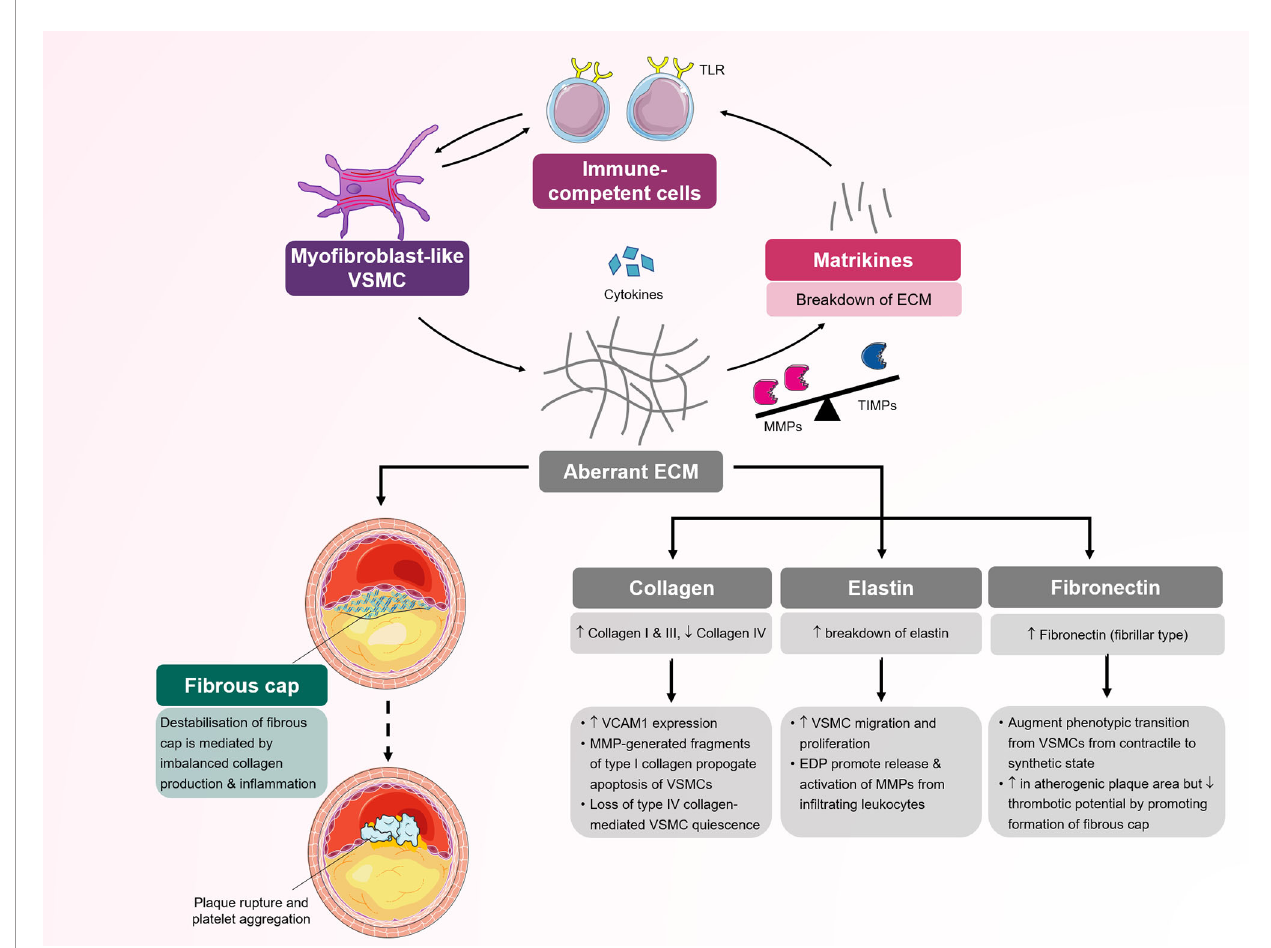
FIGURE 2 | The roles of different vascular smooth muscle cell (VSMC) phenotypes in the initiation, progression and sequelae of atherosclerotic lesions. The normal artery has a trilaminar structure. The adventitia (outermost layer) contains vasovasrum, mesenchymal stem cells and collagen. The tunica media (middle layer) contains quiescent VSMCs, tissue resident macrophages and media progeny-derived VSMCs. Atherosclerosis begins in the intima (innermost layer). (1) VSMCs migrate into the tunica intima in response to in fl ammatory mediators and differentiate into macrophage-like VSMCs. Macrophage-like VSMCs and endothelial